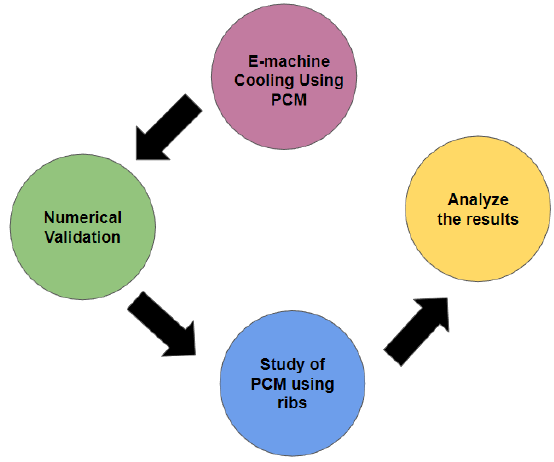
Figure 2. Research design of thermal analysis.